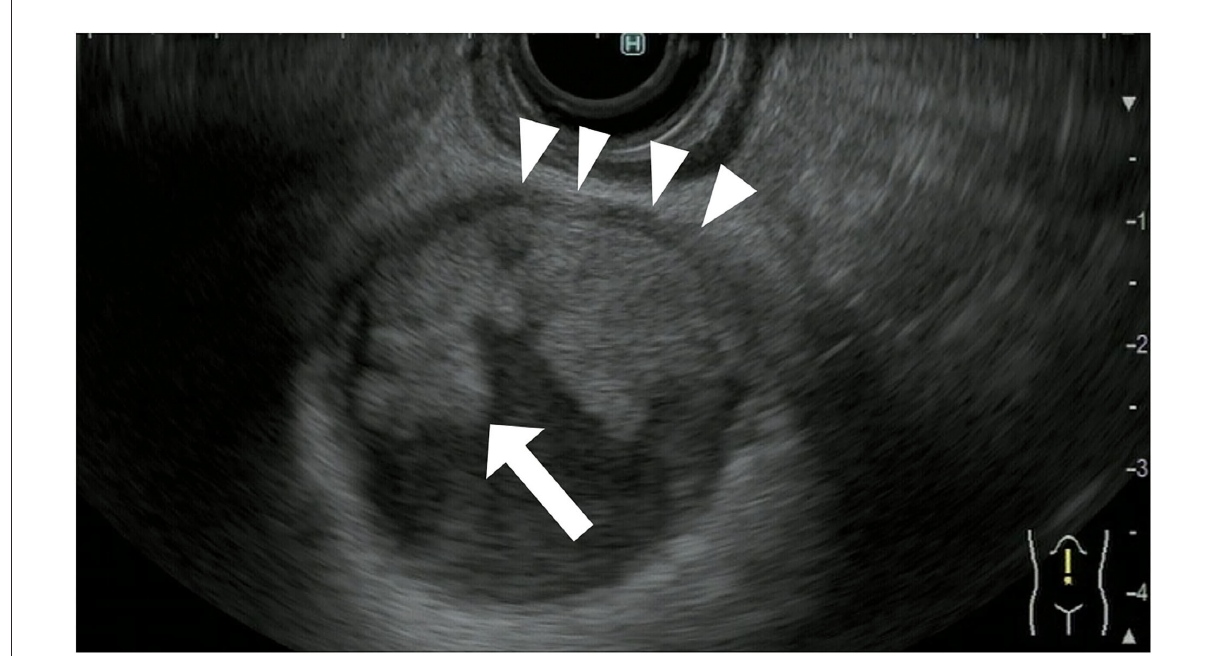
FIGURE8 Fundamental B-mode EUS for staging of gallbladder carcinoma. T3 gallbladder carcinoma: hypoechoic tumor (arrow) in the gallbladder without a disrupted hyperechoic layer (arrowhead).